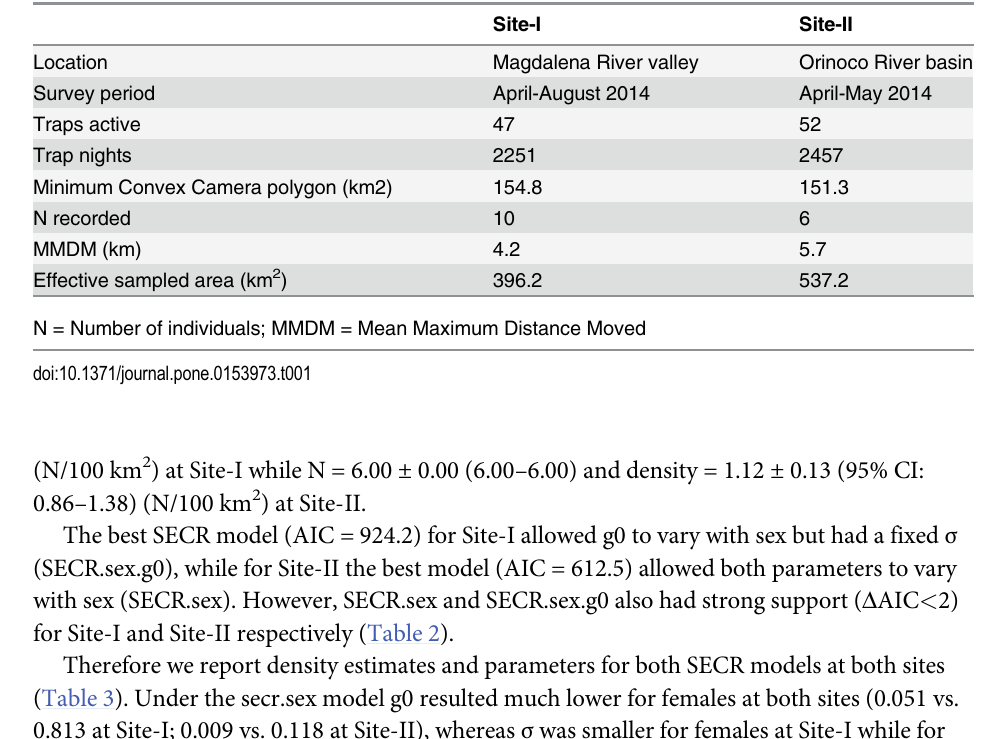
Table 1. Parameters and survey features for Site-I and Site-II.